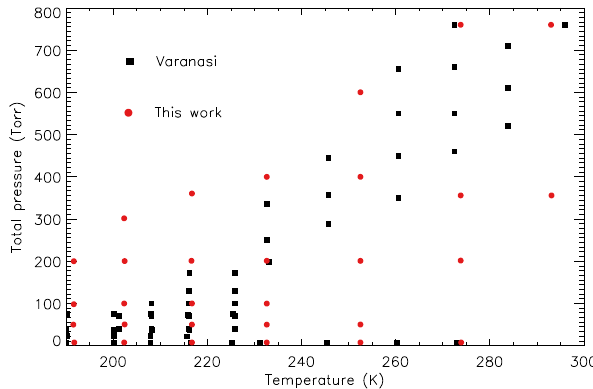
Figure 6. A graphical representation of the PT coverage for both the new and Varanasi